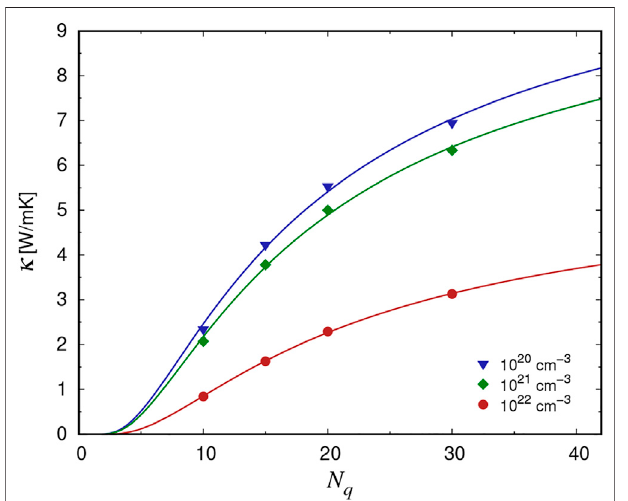
FIGURE2| ThermalconductivityinSi 0.5 Ge 0.5 asafunctionofthedoping level for various dopants. The horizontal gray line indicates the thermal conductivity in undoped Si 0.5 Ge 0.5 .